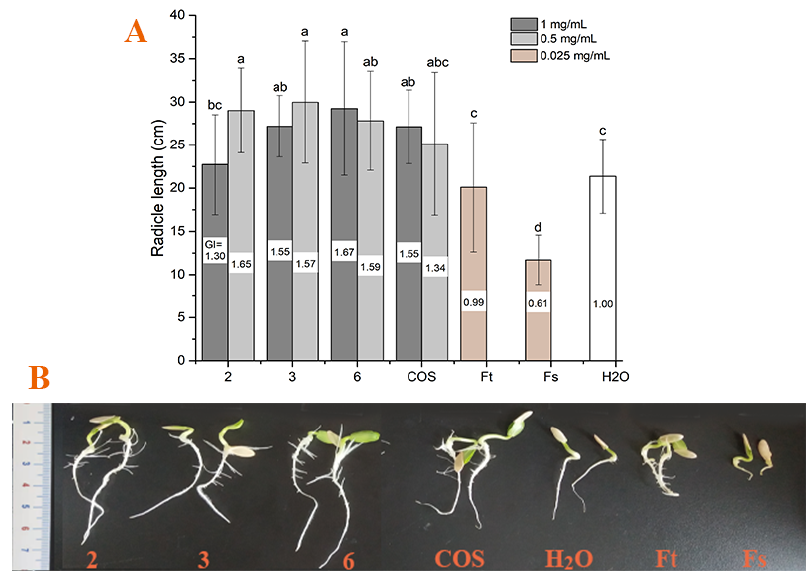
Figure 7. Phytotoxicity of COS derivatives: ( A ) was the effect on radicle length, and the number in the center of histogram is GI value; ( B ) was the effect on seed germination. Different letters (a, b, c, etc.) above histogram mean statistical significance at the p ≤ 0.05 level.